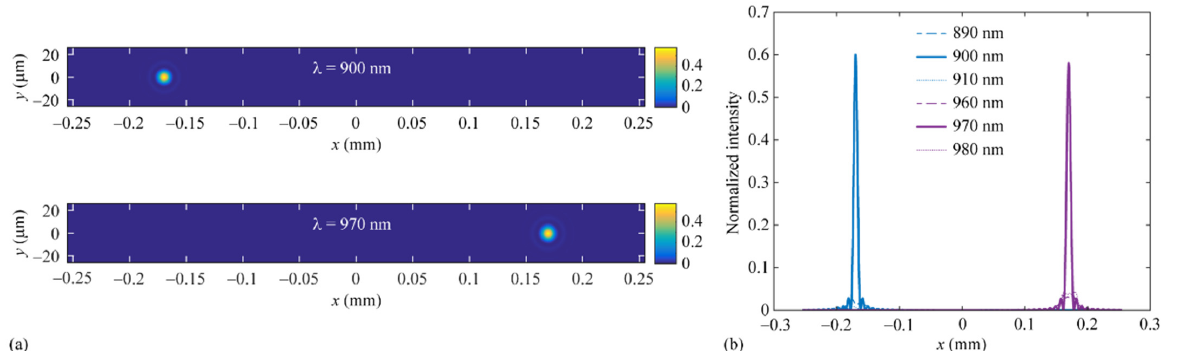
Figure 4. ( a ) Normalized two-dimensional intensity distributions generated by the calculated MWDL at the design wavelengths λ 1 = 900 nm (top) and λ 2 = 970 nm (bottom); ( b ) Cross-sections of the normalized intensity distributions along the x axis for the wavelengths λ 1 , λ 1 ± 10nm and λ 2 , λ 2 ± 10